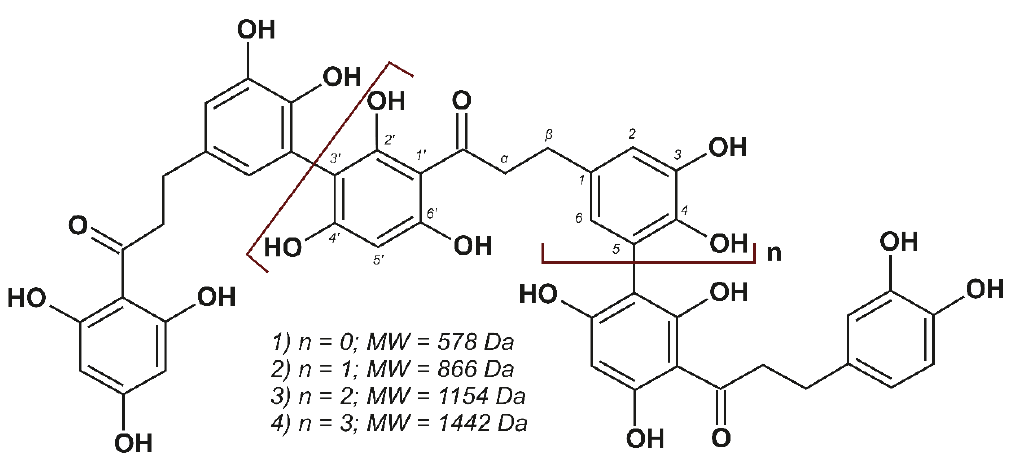
Figure 3. Chemical structure of 3-hydroxyphloretin oligomers listed in Table 1.